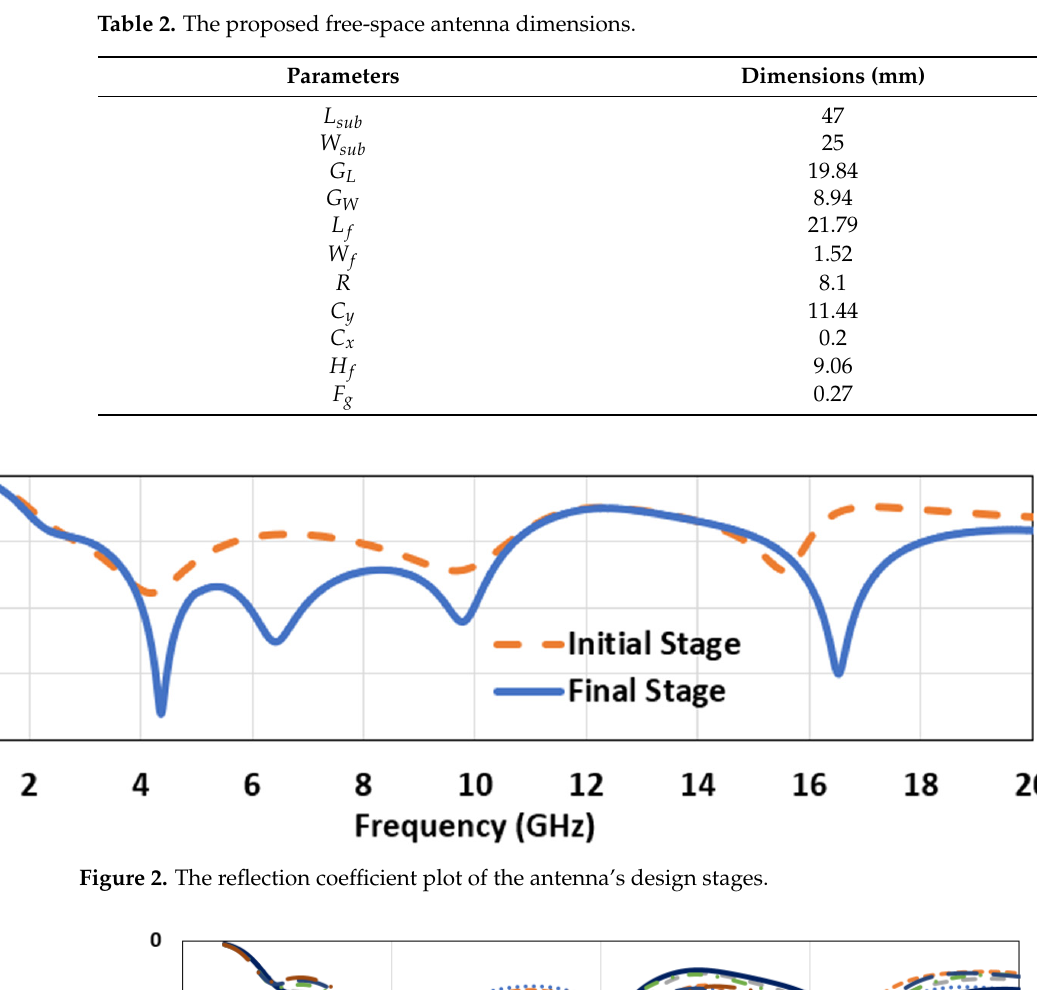
Figure 4. The reflection coefficient plot ( (cid:1845) (cid:2869)(cid:2869) ) for different feedline cut depths ( C x ) (cut length, C y = 11.44 mm).